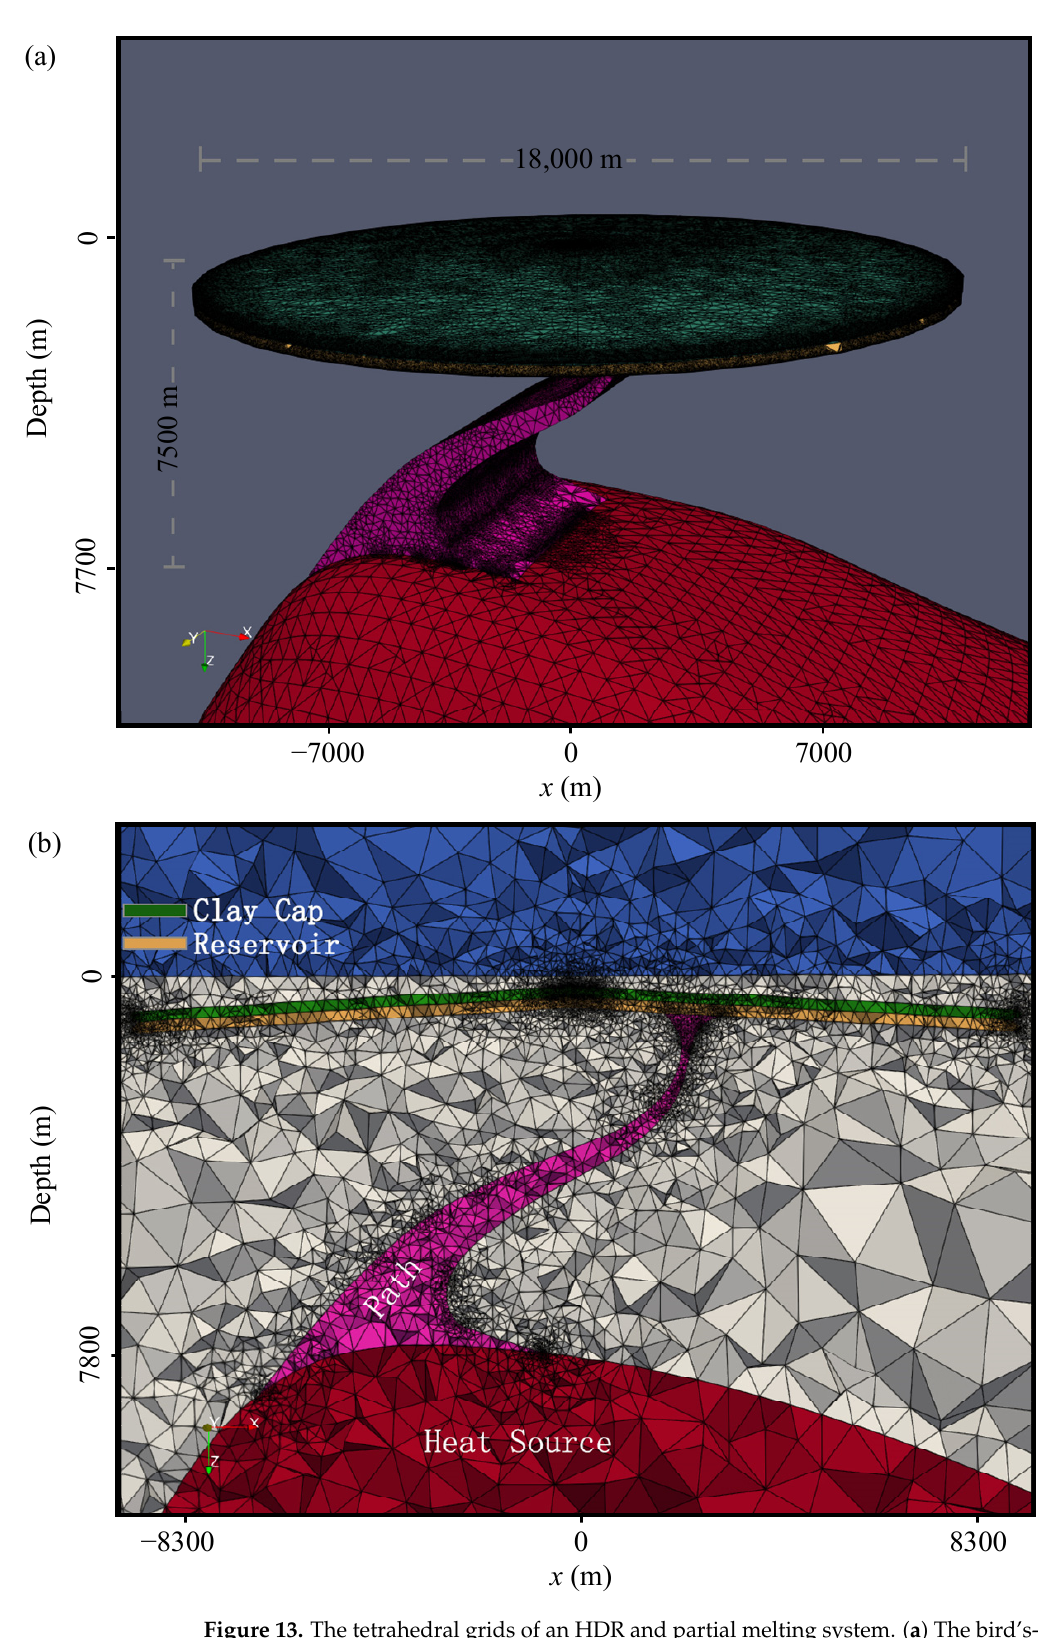
Figure 13. The tetrahedral grids of an HDR and partial melting system. ( a ) The bird’s-eye view of the conductive block. ( b ) The section view of y = 0 m.